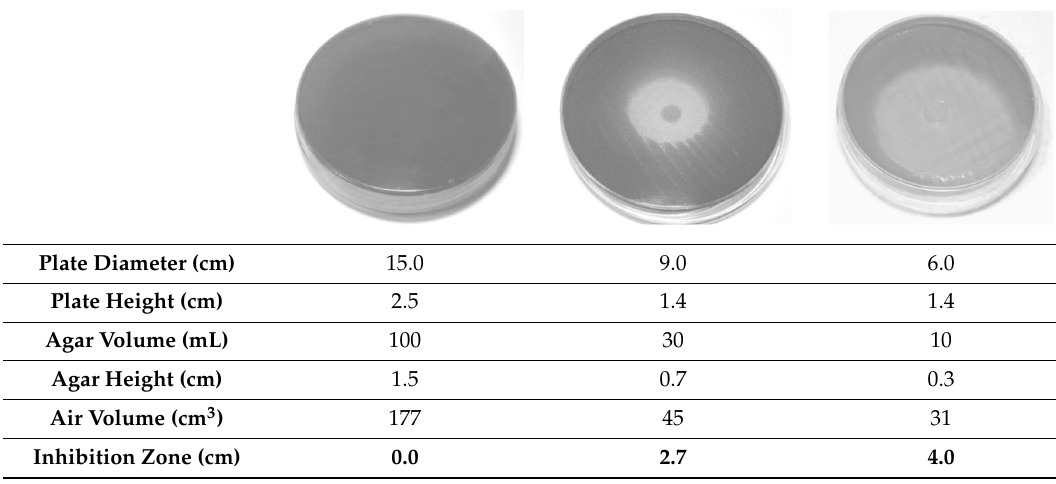
Figure 4. Comparison of antibiofilm activity of three concentrations of TT ‐ EO against S. aureus biofilm. The test was performed in a single plate for three TT ‐ EO concentrations and in separate plates for each concentration. TT ‐ EO 25%, 50%, 100%—biofilm treated with 25%, 50% or undiluted (100%) tea ‐ tree oil, respectively. Values with the same letters show a lack of significant difference ( p < 0.05, K–W test, followed by Tukey’s analysis) between the impact of the same concentrations of TT ‐ EO within two experimental settings applied (all TT ‐ EO concentrations in a single plate vs. single TT ‐ EO concentration in a single plate). Table 1. Dependence between Petri dish diameter and size of S. aureus growth inhibition zone after exposure to T ‐ EO. Inverted Petri dish method (also known as disc volatilization method).